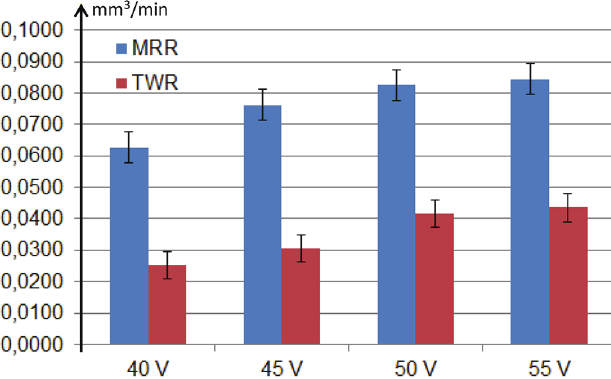
Fig. 5. Effect of U on MRR and TWR in EDM using coated electrode.